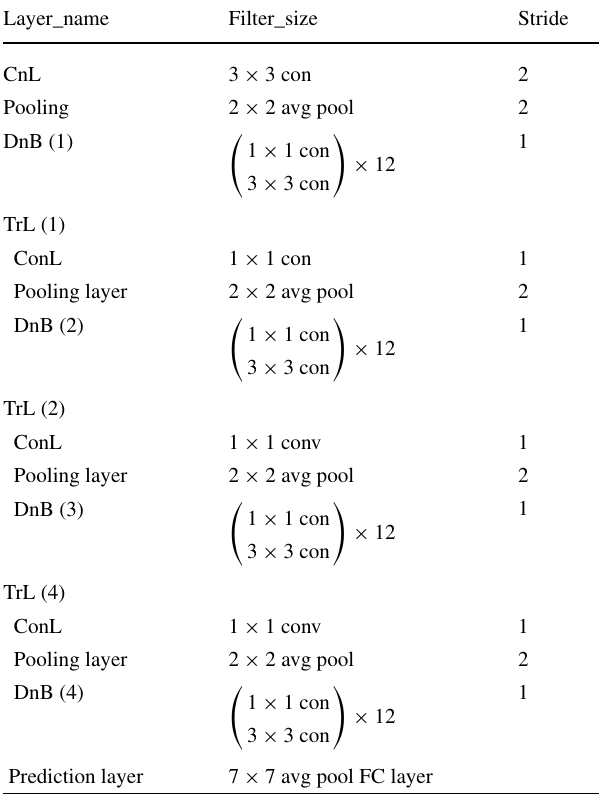
Table 2 Structure of